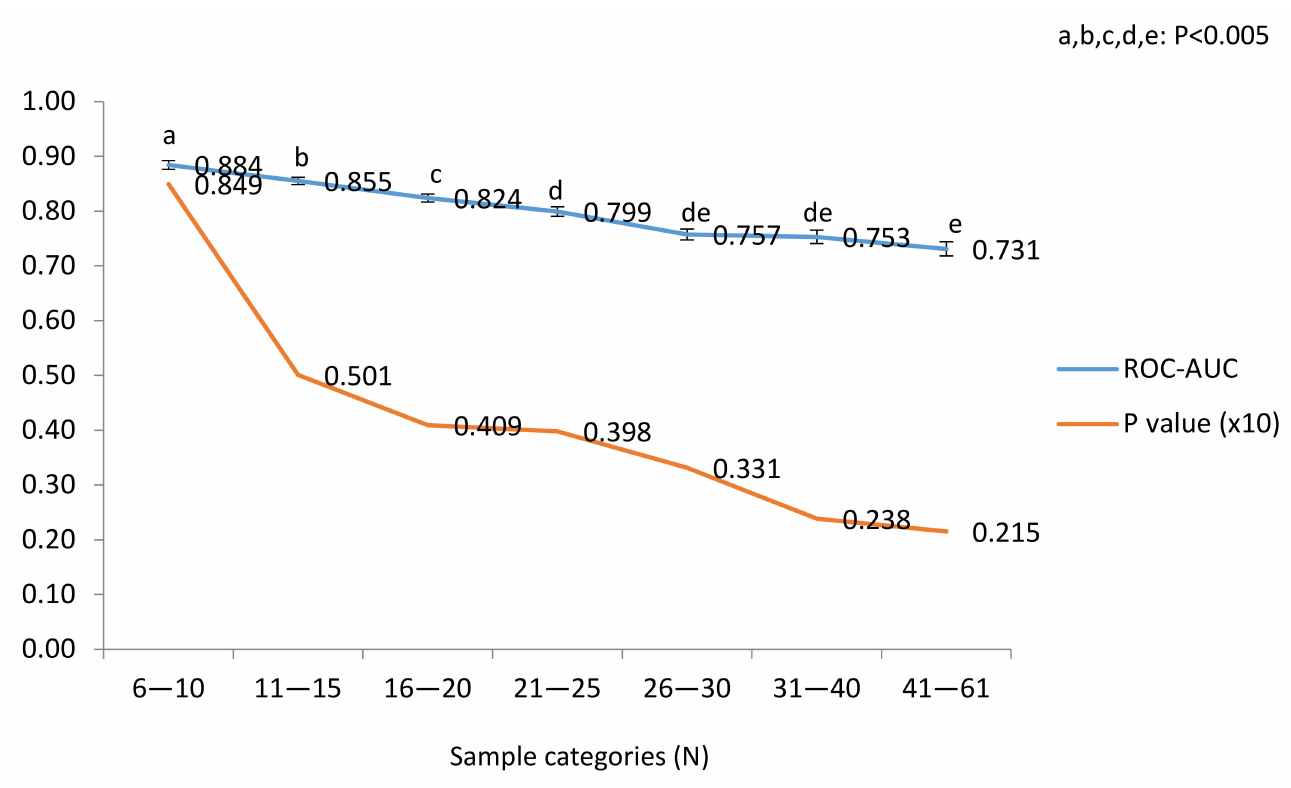
Figure 5. ROC-AUC and their p -value averages plotted by categories of sample numbers (Pearson’s correlation coefficients are shown). p -values given in a × 10 basis for scale consistency with ROC-AUC. Data from n = 511 blocks distributed into 78, 131, 106, 85, 52, 30 and 29 blocks from lower to higher sample